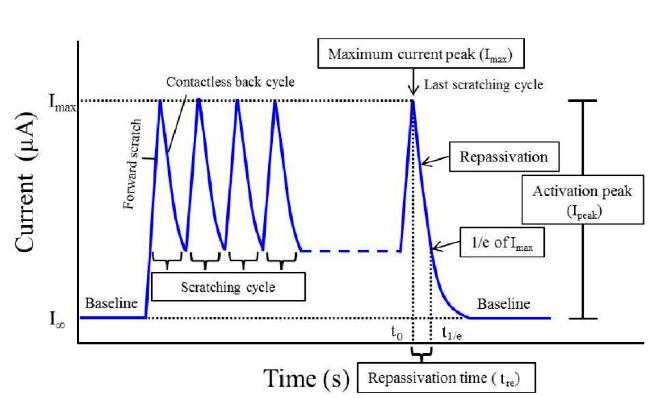
Figure 31. A typical fretting corrosion current transient [350]. Reprinted with permission from MDPI AG.